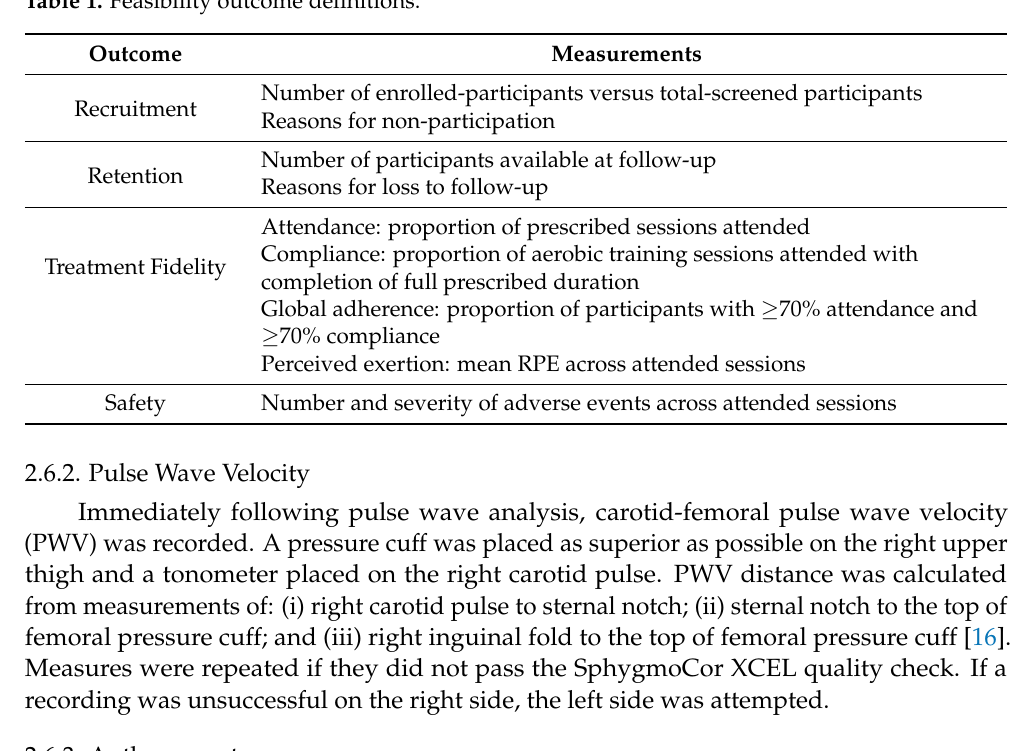
Table 1. Feasibility outcome